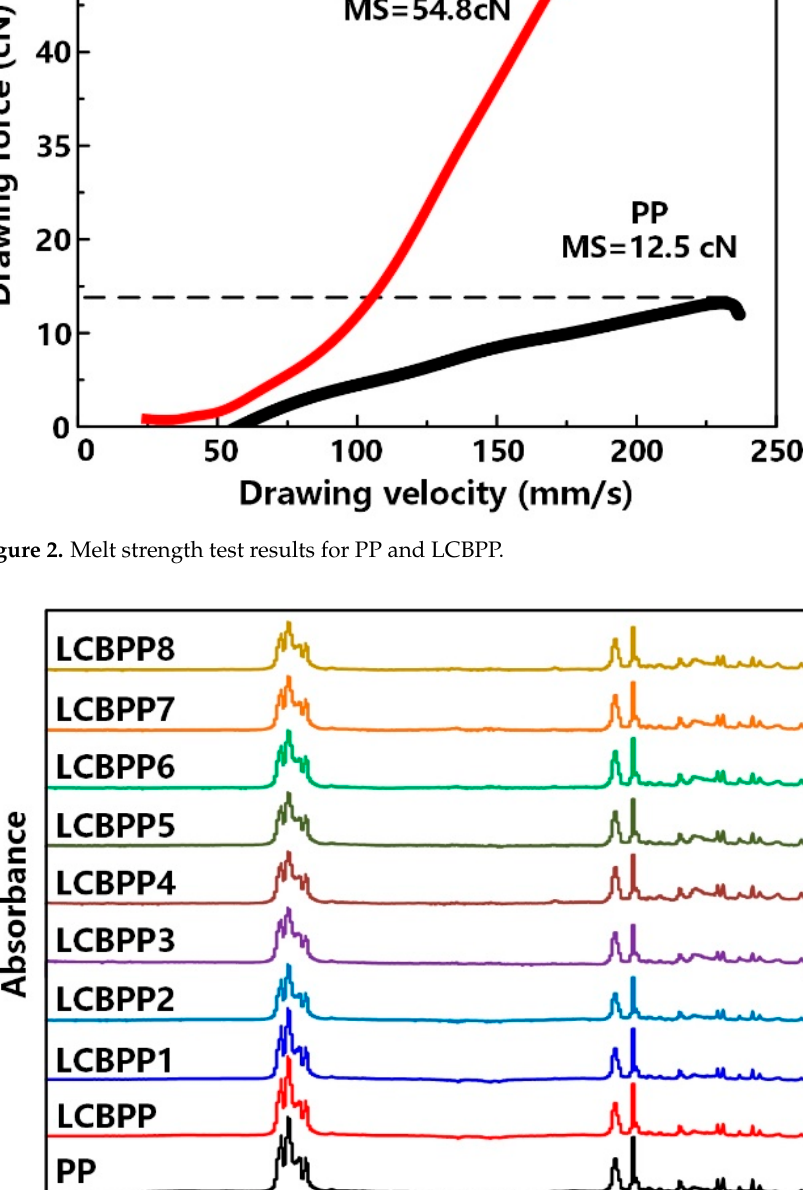
Figure 4. X-ray diffraction pattern of the test samples. Figure 5 shows the DSC test results, and the thermal parameters are shown in Table 3. Figure 5a is the crystallization curves of the samples. It can be seen that the crystalliza- tion temperature ( Tc ) of LCBPP is 6.3 °C higher than that of PP, due to the long-chain